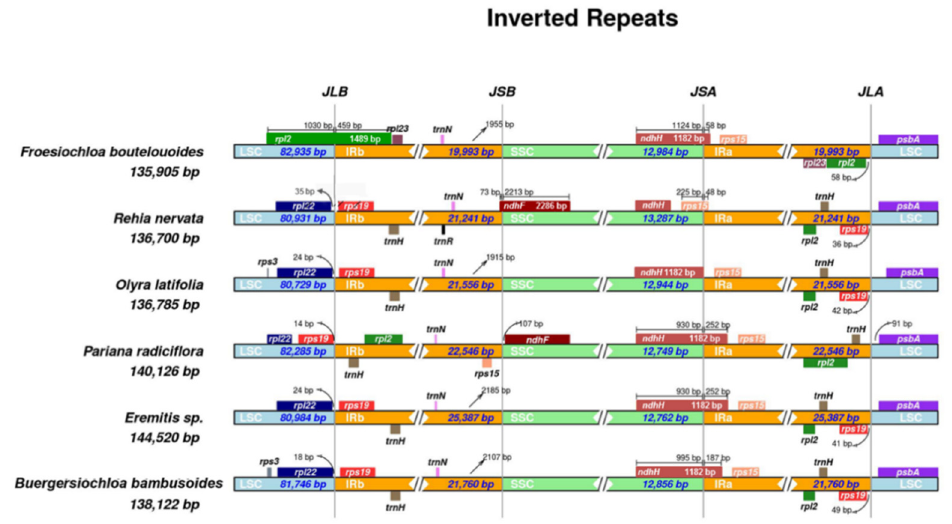
Figure 4. Comparison of IR boundaries among Olyreae chloroplast genomes. Each species and their corresponding chloroplast genome length are depicted to the left of each track. LSC: Large Single Copy region; SSC: Small Single Copy region; IRa/IRb: Inverted Repeat region a/b. JLB, JSB, JSA and JLA denote the junction sites of LSC/IRb, IRb/SSC, SSC/IRa and IRa/LSC, respectively. Genes drawn above/below the track indicate the direct/complement transcription.